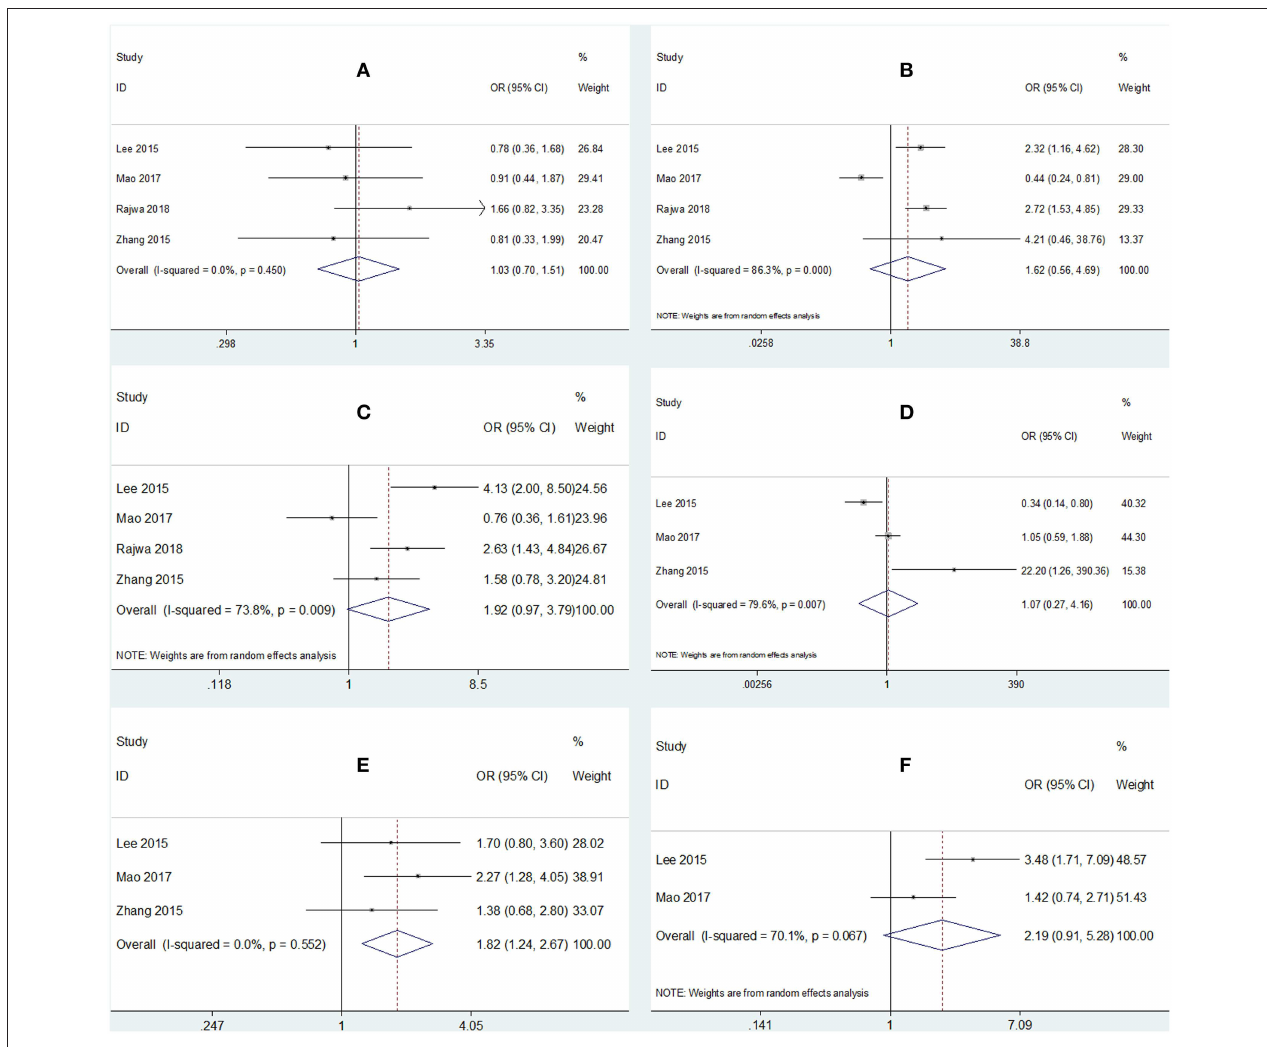
FIGURE 3 | Forrest plots of associations between PLR and (A) sex, (B) tumor grade, (C) tumor stage, (D) distant metastasis, (E) age, and (F) tumor